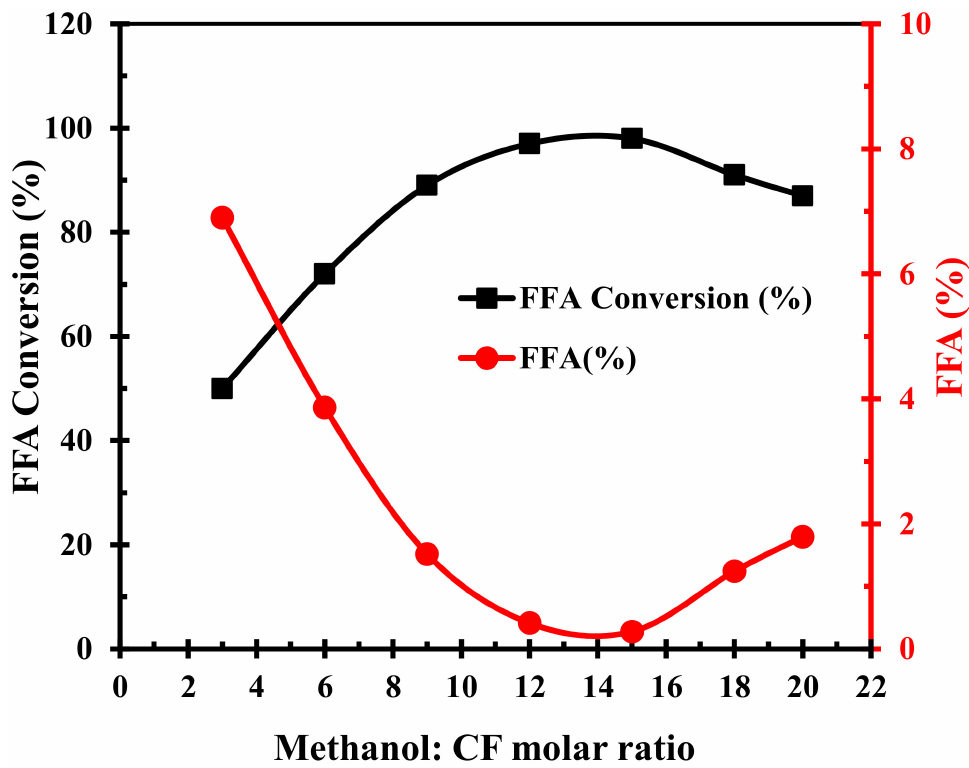
Figure 9. Effect of methanol-to-CF molar ratios FFA conversion to FAME and deacidification.